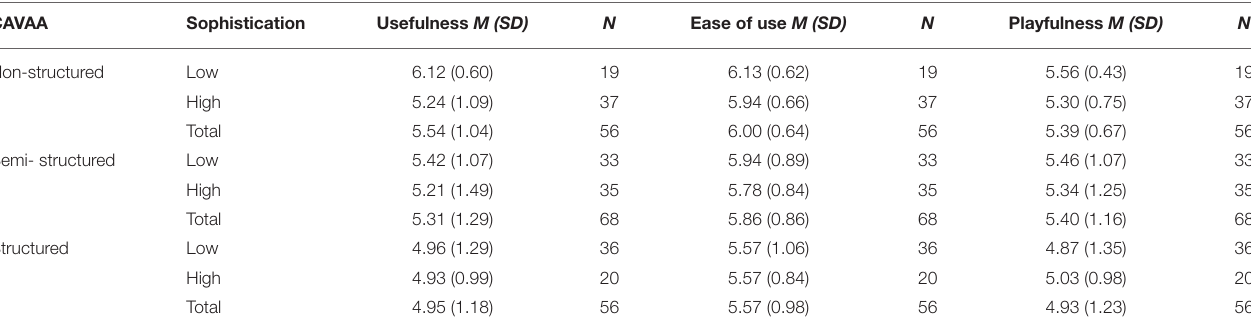
TABLE 6 | Means and Standard Deviations of the different aspects of CAVAA experience (ranging from 1 – a low evaluation to 7 – a high evaluation) in each condition. CAVAA Sophistication